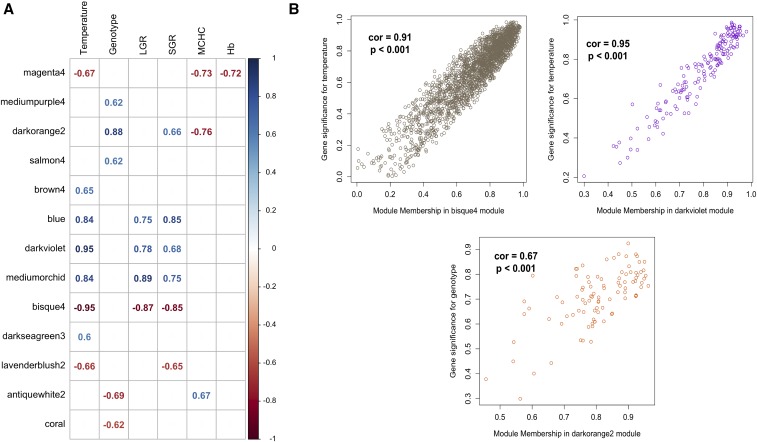
Co-expression network analysis. A) Correlation matrix from weighted gene co-expression network analysis (WGCNA). The matrix of co-expression was built on a total of 11,426 genes after removal of low-expressed genes (logCPM < 1 in at least two individuals and genes with gene expression variance < 0.1 in the global dataset). Only modules significantly correlating (p-value < 0.01) with temperature or genotype are represented. Values indicate the correlation value (R). B) Correlation between module membership and gene significance for the modules with the highest correlation to temperature (modules bisque4 and darkviolet) and genotype (module darkorange2).